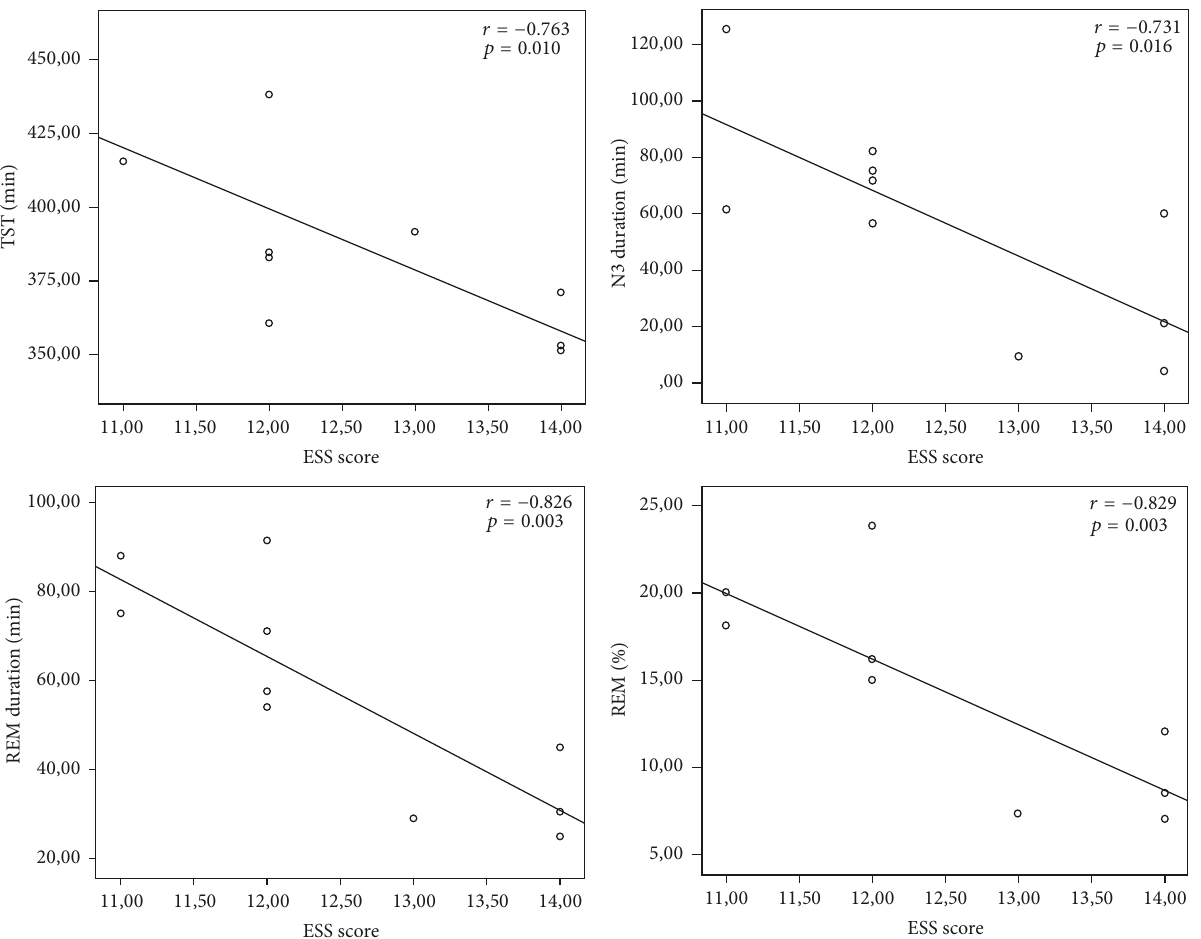
Figure 2: Associations between ESS score and TST and N3 duration and REM duration and REM